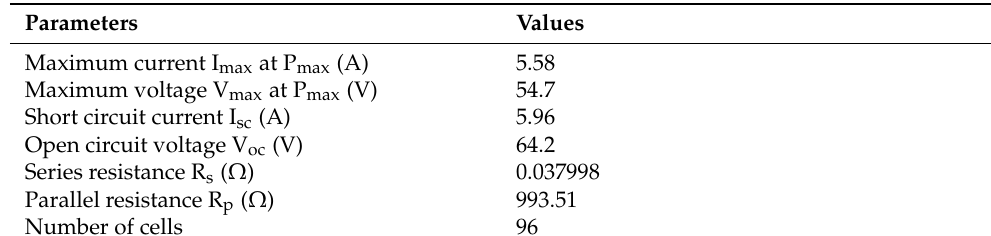
Table 2. The PV panel parameters.